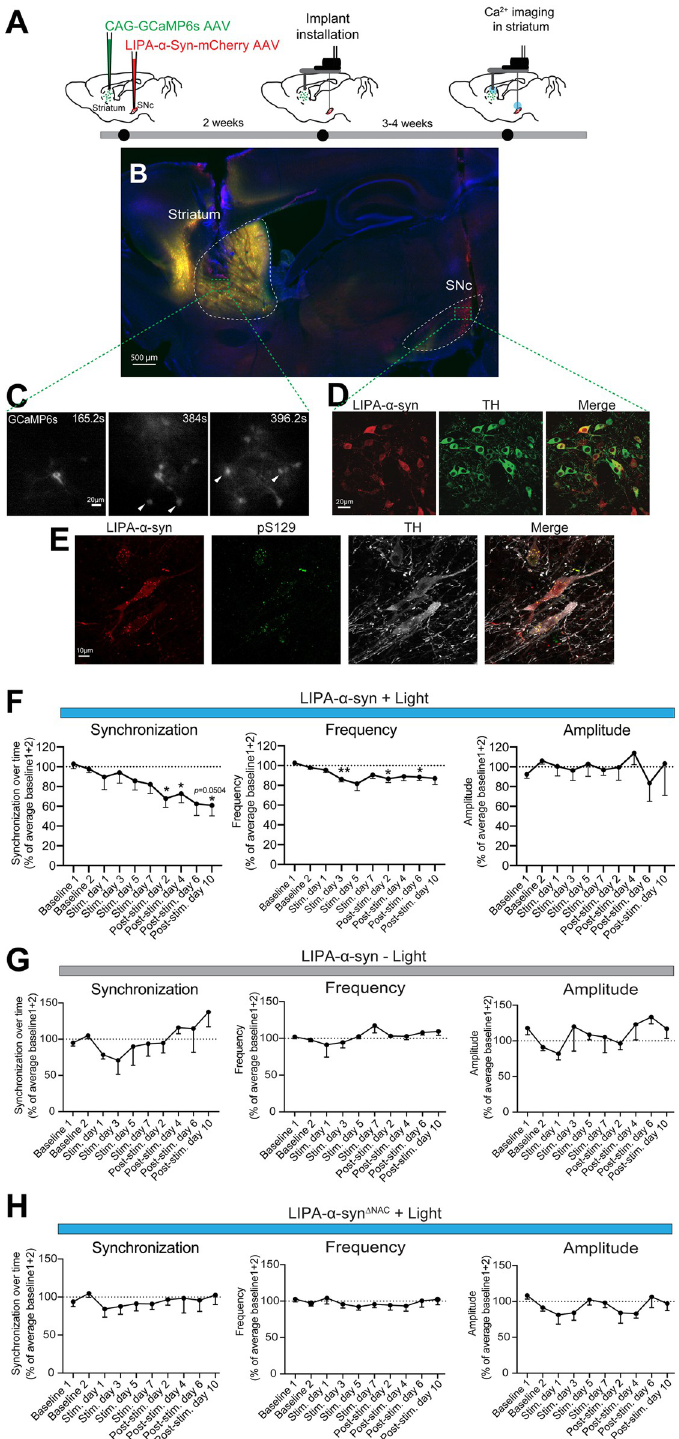
Fig 5. LIPA- α -syn aggregation disrupts nigrostriatal neuronal transmission. ( A ) Schematic representation of the in vivo experimental paradigm of light-induced α -syn aggregation in the SNc and Ca 2+ imaging in the striatum. ( B ) Confocal AU : PleaseaddscalebarinformationforfiguresubpartsFig 5 Band 5 Cinthecaption : microscopy image reconstitution of a sagittal brain slice illustrating the expression of LIPA- α -syn in the SNc and the Ca 2+ indicator GCaMP6s in the striatum ( n = 5 mice) (scale bar = 500 μ m). ( C ) Representative time-lapse live imaging illustration of mini-endoscopic Ca 2+ in the striatum. Arrowheads indicate striatal neurons showing Ca